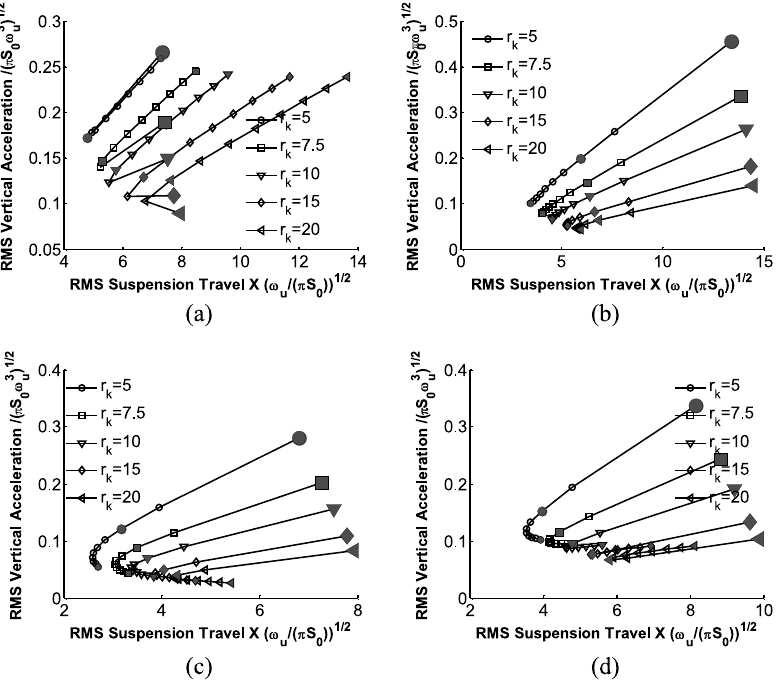
Fig. 4. Relationship between RMS acceleration and RMS suspension travel with layout s8 (effect of primary spring stiffness and damping): (a) Passive; (b) Groundhook; (c) Hybrid; (d) Skyhook. from low values to midrange values results in a lower RMS suspension de fl ection. As damping values get high, this trend is reversed for the Skyhook con fi guration, and also for the Hybrid con fi guration as the damping gets even